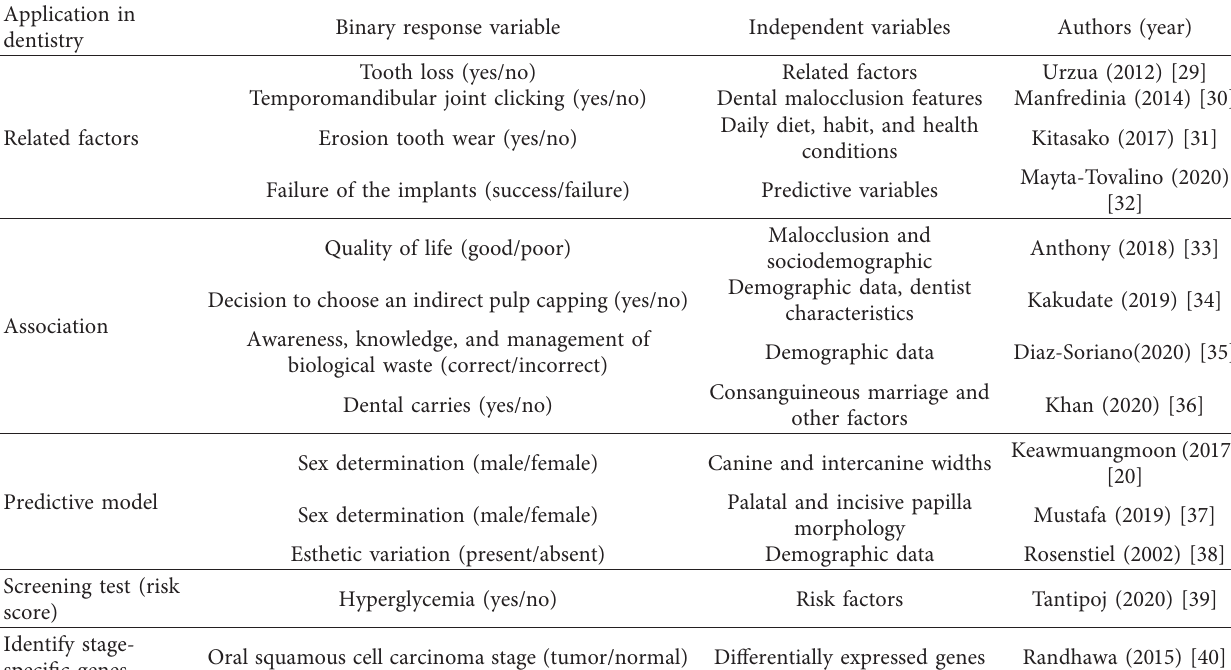
Table 5: Application of binary logistic regression in